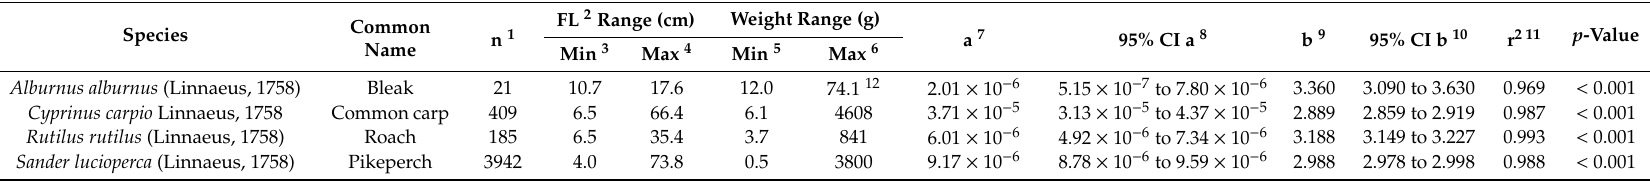
Table 1. Descriptive statistics and estimated parameters of length–weight relationships (LWR: W = a L b ) for four fish species from the Estany d’Ivars i Vila-sana shallow lake, Northeastern Spain.